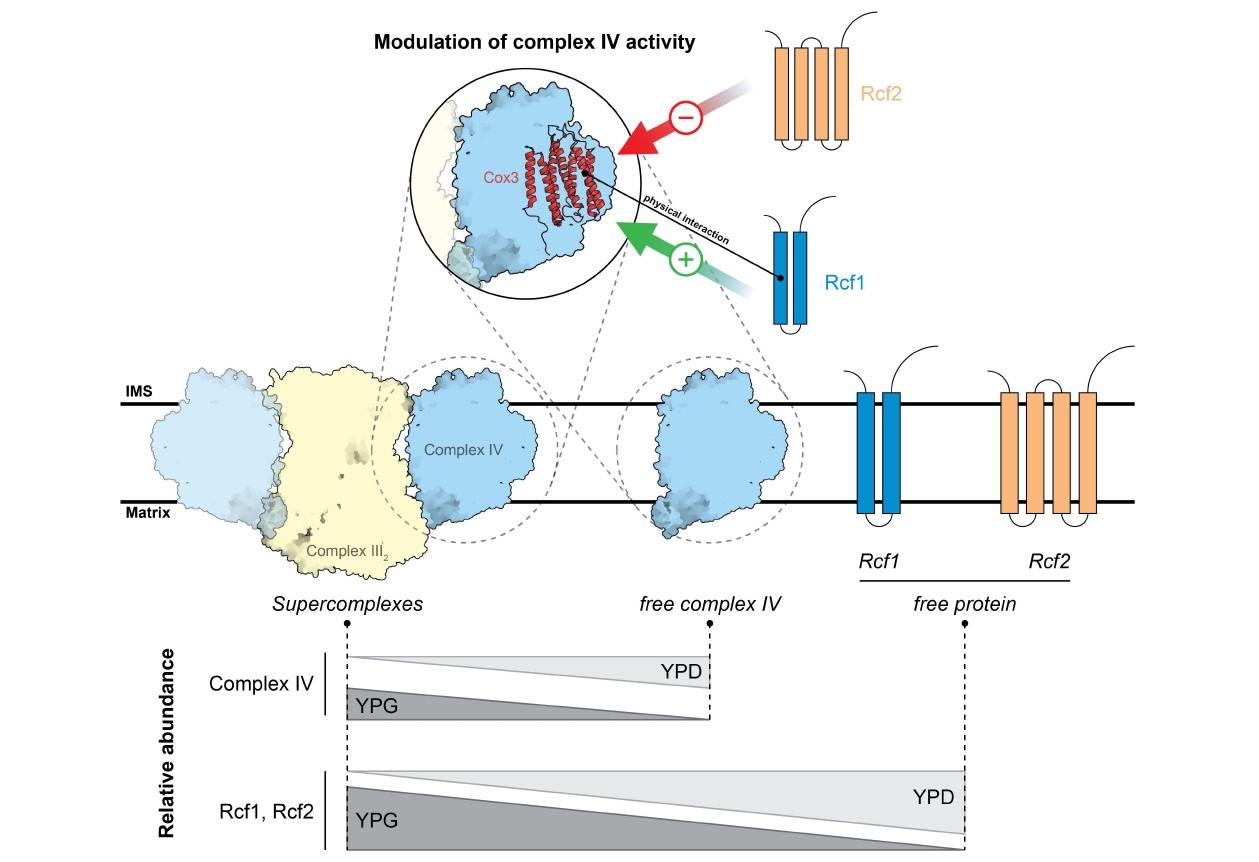
FIGURE 7 | Model of Rcf1 and Rcf2 modulating cytochrome c oxidase upon metabolic changes. Rcf1 positively modulates cytochrome c oxidase activity while Rcf2 has a negative effect. Upon a high working load of the respiratory chain under non-fermentable conditions (YPG) Rcf1 and Rcf2 shift overproportional into supercomplexes compared to a slight shift of cytochrome c oxidase subunits. Therefore, we speculate that the respiratory chain must be tightly regulated or has higher need of repair under a high working load. Structures are adapted from PDB ID: